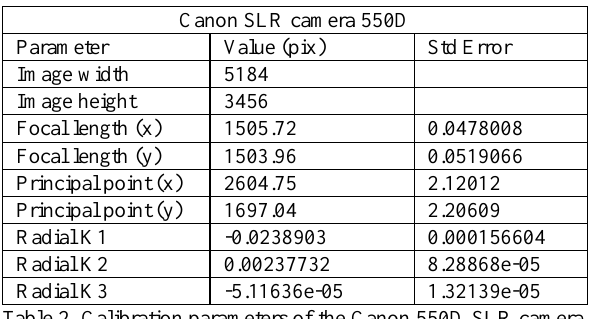
Table 2. Calibration parameters of the Canon 550D SLR camera in Agisoft Lens.